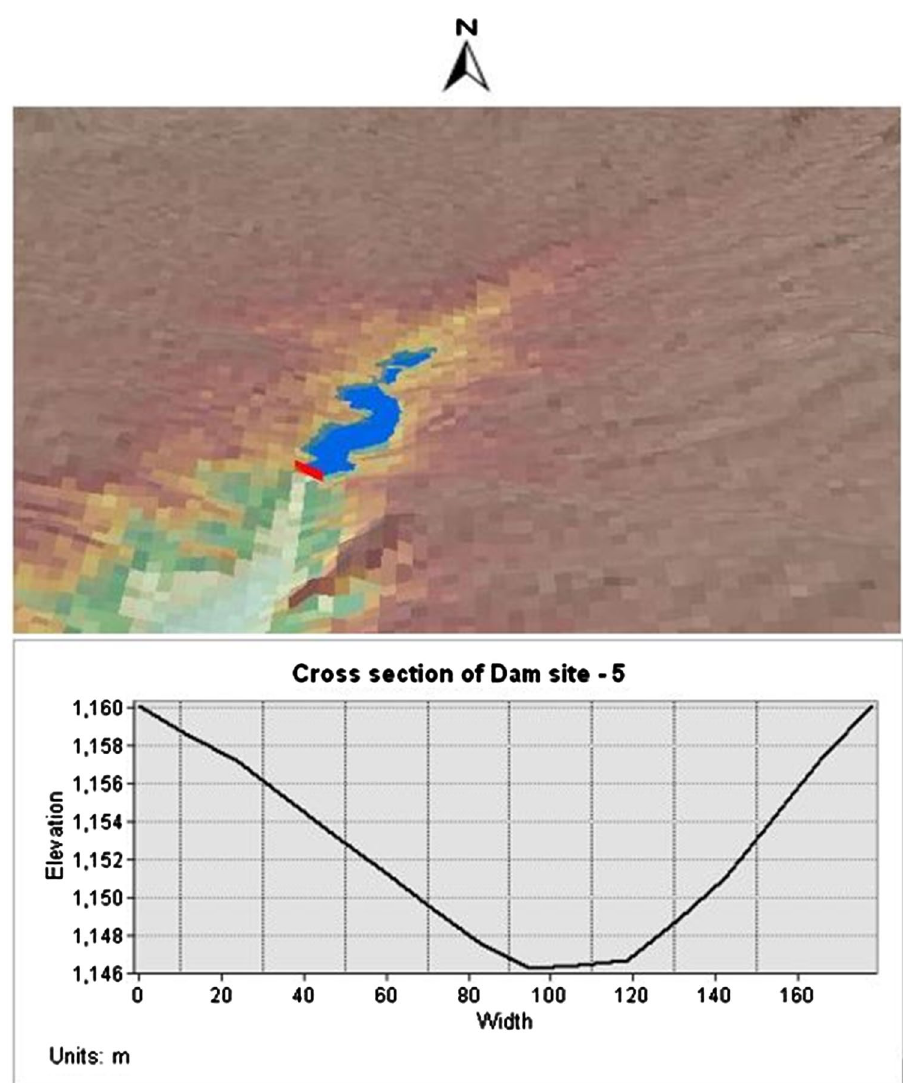
Fig. 21 3D view and cross sec- tion of proposed dam